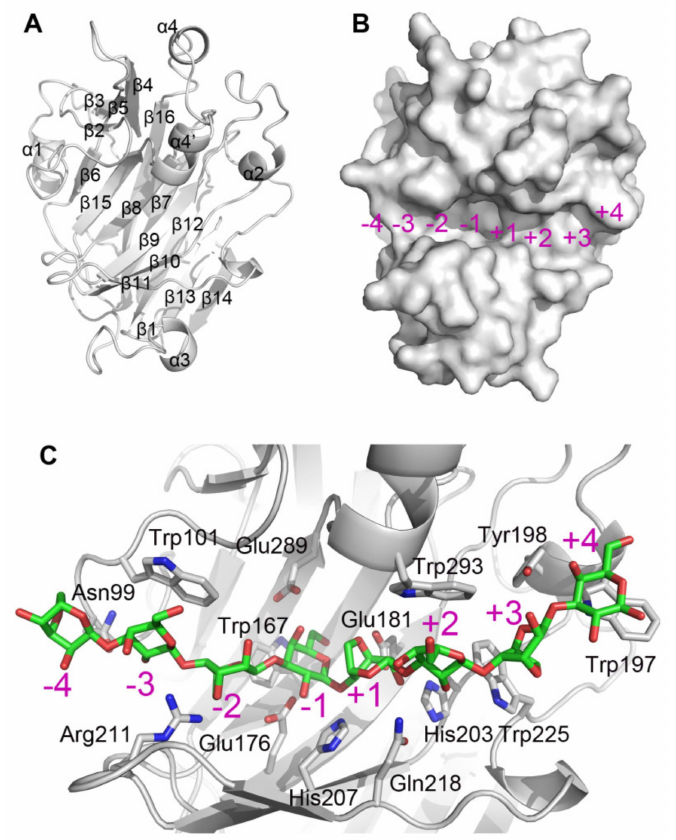
Figure 2. Structural model of Ca Aga1 and the interaction detail between Ca Aga1 and the agarose chain. ( A ) A ribbon presentation of Ca Aga1 with labeled secondary structural elements. ( B ) A surface presentation of Ca Aga1. The number and location of subsites in the substrate-binding cleft are shown. ( C ) A model of Ca Aga1 in complex with neoagarooctaose (NA8) obtained by superposing the structures of Ca Aga1 and the Zg AgaB-NA8 complex (PDB entry: 4ATF). The amino acid residues participating in the interaction with the agarose chain are presented in stick. The carbon atoms in NA8 and amino acid residues from Ca Aga1 are shown in green and gray,